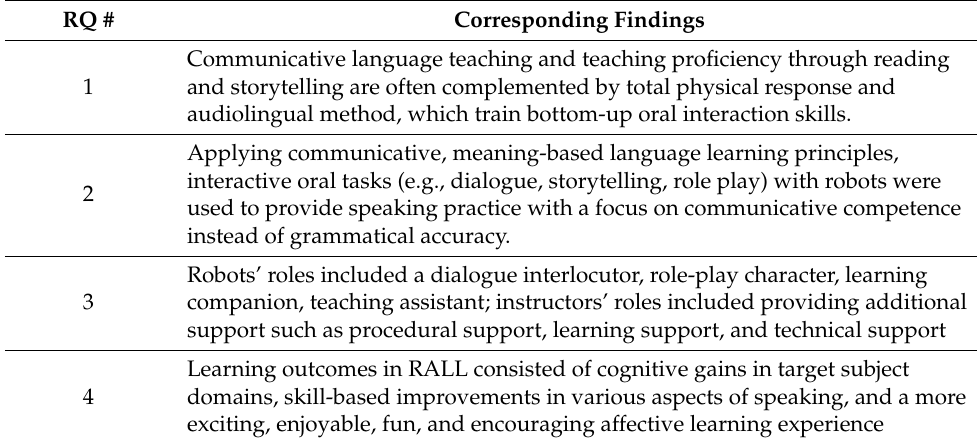
Table 4. Alignment of research questions to review findings on